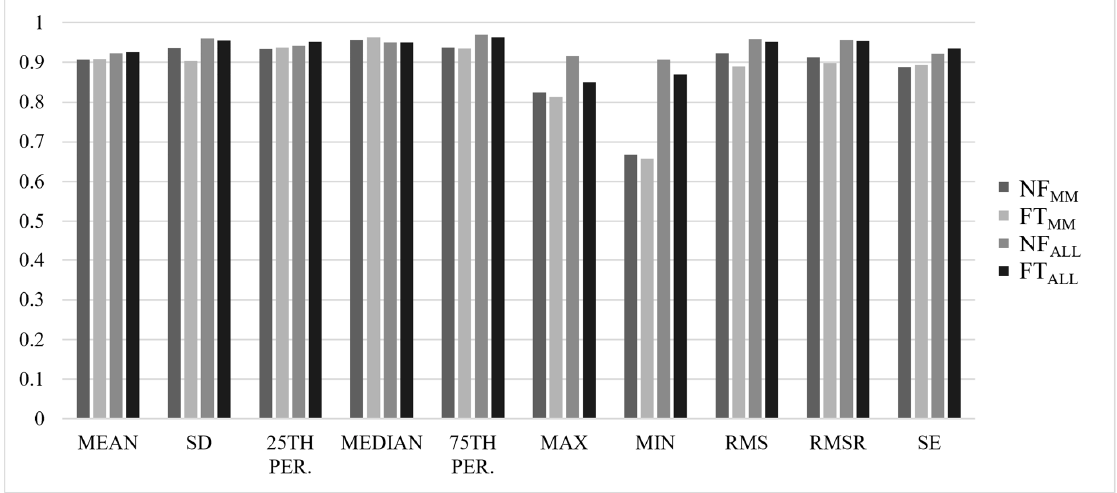
Figure 3. ICC(2, k ) values for all analyses in the anterior–posterior (AP) axis of the acceleration signal.